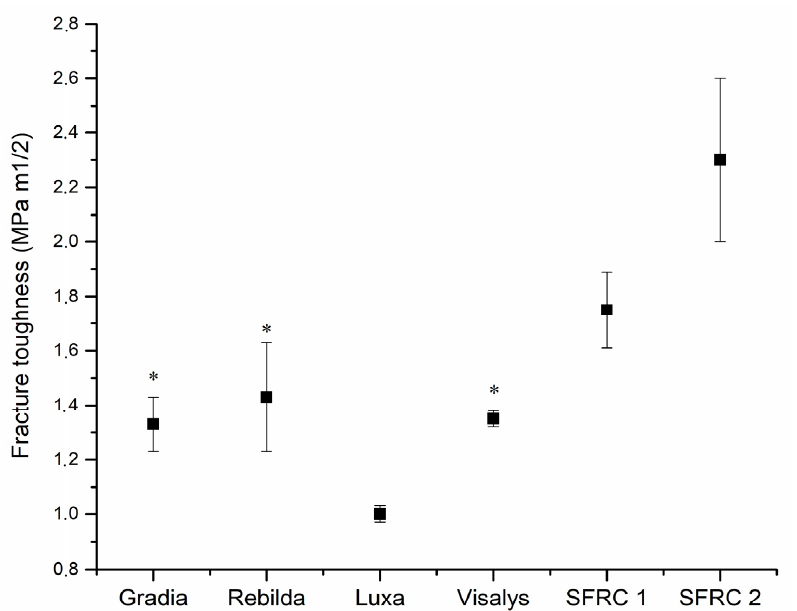
Figure 2. Graph showing mean fracture toughness (KIC) with standard deviations (SD) of inves- tigated DC resin composites. The asterisk* above the boxes indicates statistically similar groups ( p > 0.05).